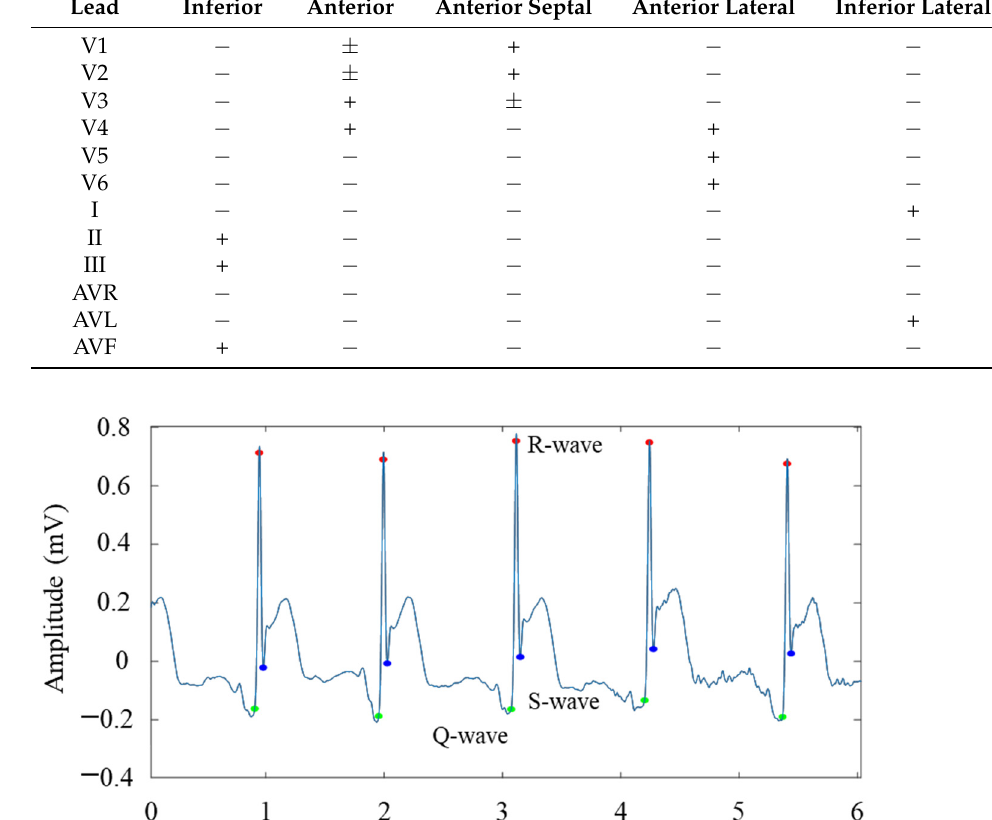
Figure 6. Localization results of the Q wave, R wave, and S wave of the AVF lead in patients with inferior myocardial infarction.